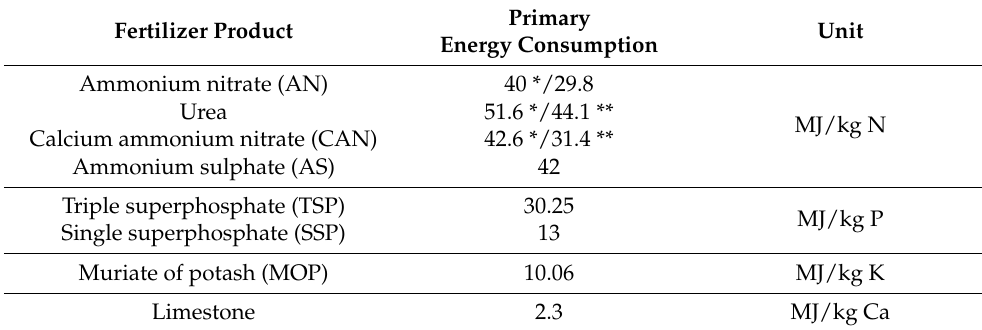
Table 4. Energy consumption for producing, packing, and delivering the main types of fertilizers [43]. Primary Fertilizer Product Energy Consumption